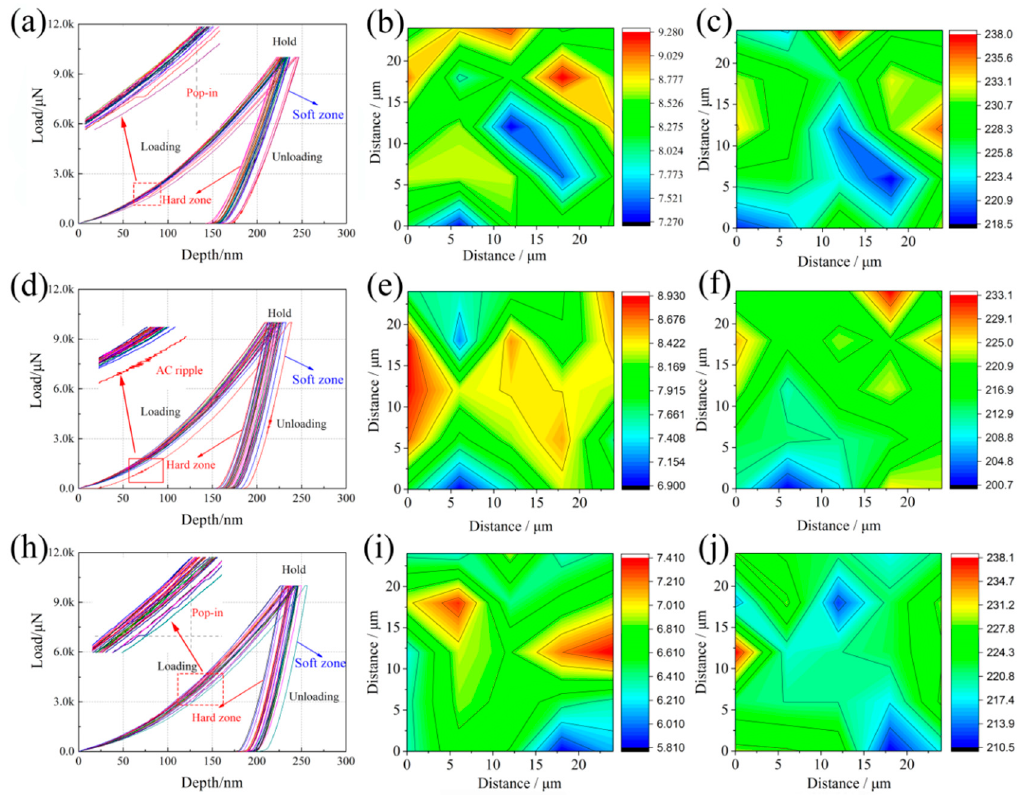
Figure 11. Nano-hardness load-displacement curves, the corresponding distributions of the nano- indentation hardness and elastic modulus in the nano bainitic coatings obtained at 200 °C ( a , b , c ); 250 ( a – c ); 250 ◦ C ( d – f ); 300 ◦ C ( h – j °C ( d , e , f ); 300 °C ( h , i , j ).